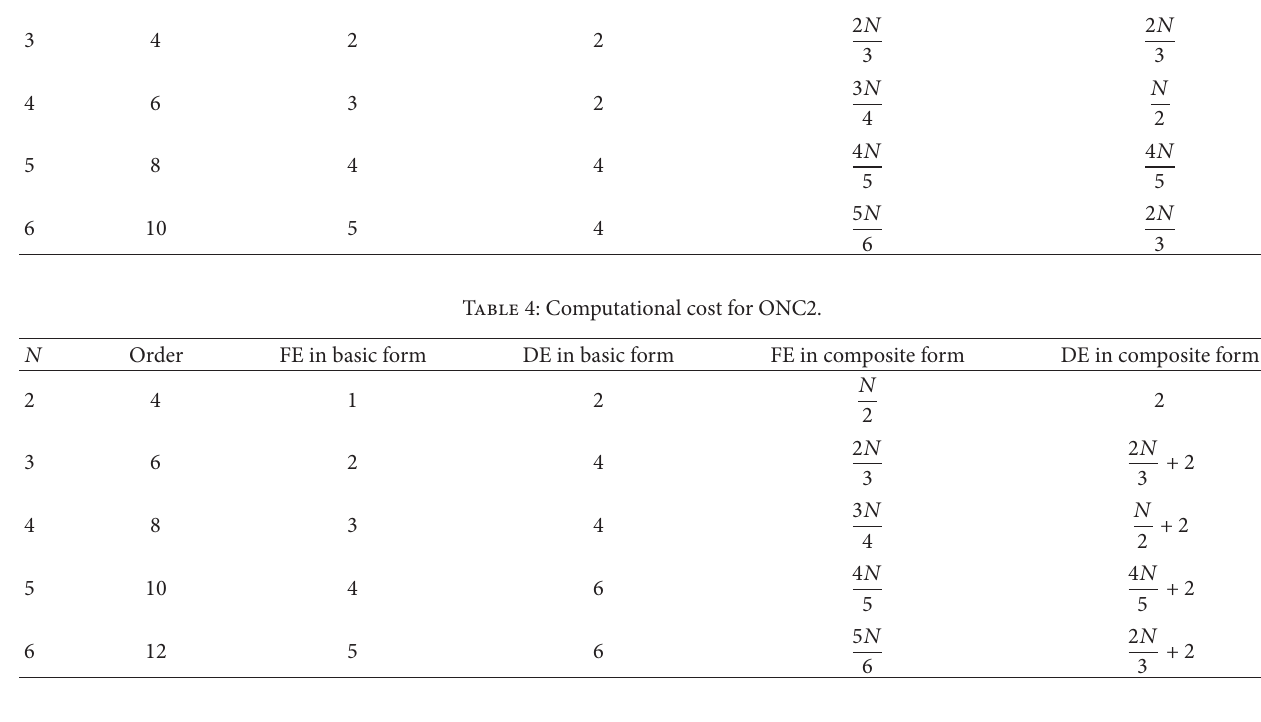
Table 5: Computational cost for